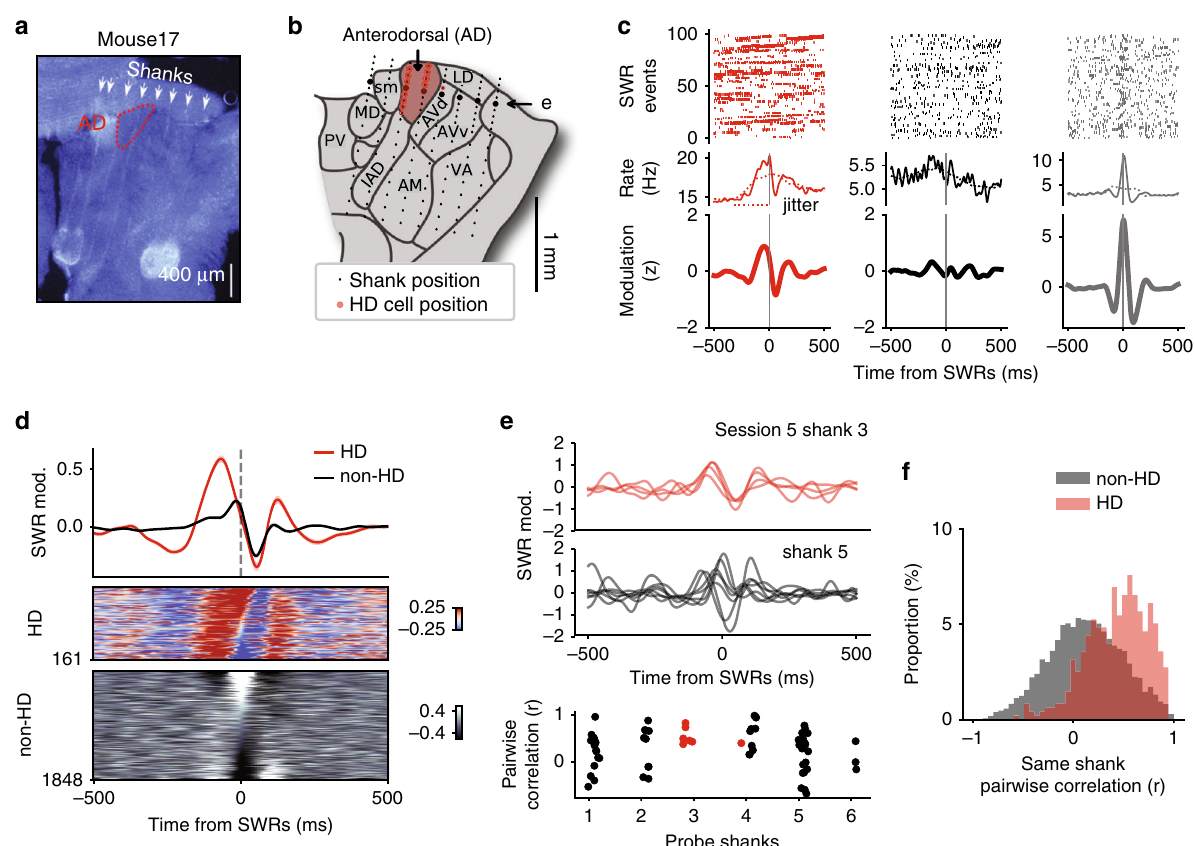
Fig. 2 Homogeneous coupling of HD, but not non-HD neurons to SWRs. a Histology of an example mouse (Mouse 17, DAPI staining). Note the tracks of the eight-shank silicon probe and lesion sites at the end of the tracks. Contour of the AD nucleus is shown in red. b Schematic of the AT (coronal plane) with recording sites (black dots) for the same animal as in a . Red dots indicate where HD neurons were detected. c Top, spikes for successive SWRs. Middle, mean fi ring rates. Bottom, z -scored modulation (see text) for one HD neuron (red) and 2 non-HD neurons (gray) differently modulated by SWRs. d Top, average SWRs modulation (±s.e.m.) for HD (red) and non-HD neurons (black) for all sessions. Middle, bottom, SWR cross-correlograms for HD neurons (top) and all other AT neurons (bottom). Neurons were sorted according to the level of correlation with SWR at zero-time lag. e Examples of SWR cross-correlograms for HD (top) and non-HD neurons (middle) recorded during the same session but on different shanks (arrow in b ). Bottom, Pearson ʼ s correlation coef fi cients between SWR cross-correlograms of pairs of neurons recorded on the same shanks. Red dots indicate pairs of HD neurons. f Distribution of Pearson ’ s correlation coef fi cients between SWR cross-correlograms of pairs of HD (red) and non-HD (gray) neurons (similar to e ) recorded on the same shanks, for all sessions. AD anterodorsal, AM anteromedial, AVd anteroventral, dorsomedial part, AVv anteroventral, ventrolateral part, IAD interanterodorsal, LD laterodorsal, MD mediodorsal, PV paraventricular, sm stria medullaris, VA Ventral (Fig. 3g, note that arrows point towards similar directions for theta and SWR phases). In the population of AT neurons that were signi fi cantly modulated by theta, theta phases were correlated with SWR phases (Fig. 3h; r = 0.18, p = 2.3 × 10 − 7 ,